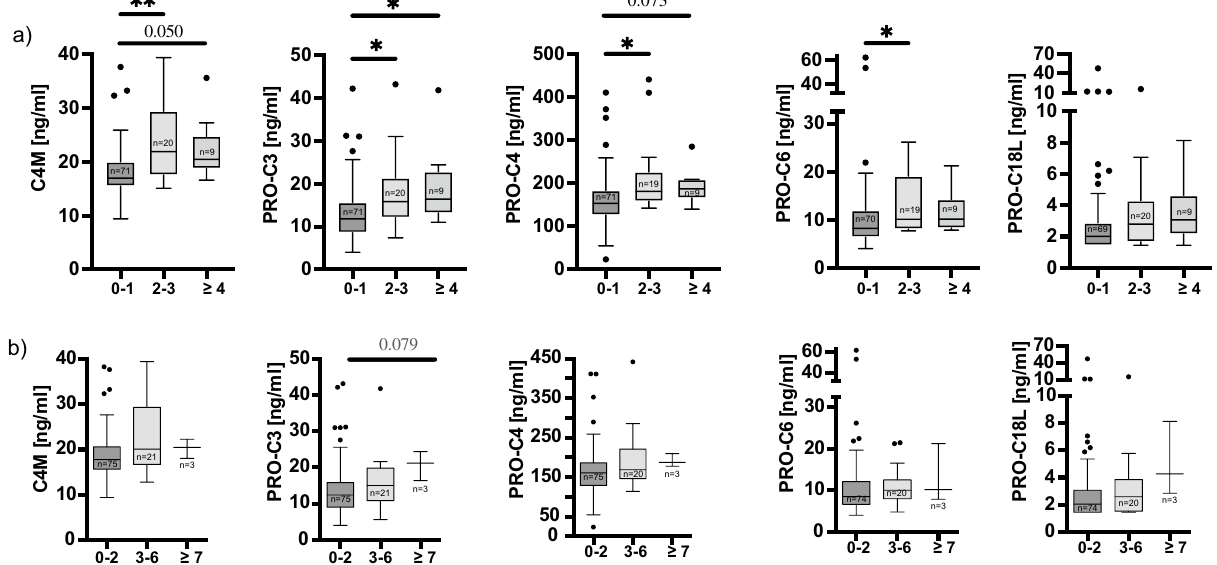
Figure 3. Correlation of ECM biomarkers with histopathological scores of fibrosis. Tukey Boxplots demonstrating differences in median biomarker levels in patients grouped according to points in Ishak fibrosis staging ( a ) and LAF-score ( b ). Kruskal–Wallis-test with Bonferroni’s post-hoc test were used for comparison between groups. *indicates p < 0.05; **indicates p <